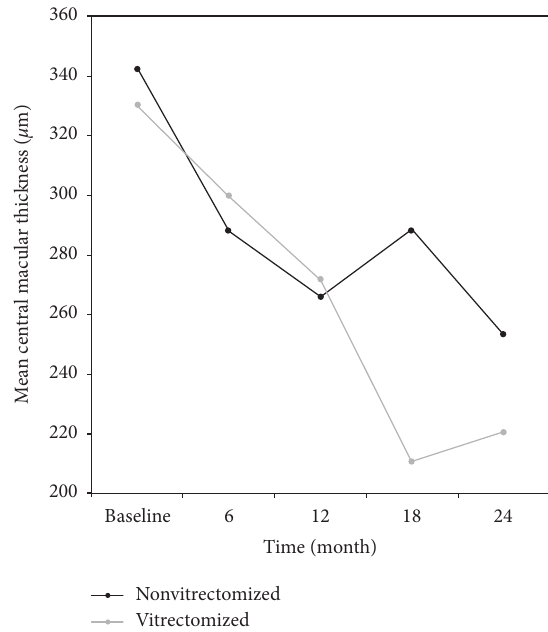
Figure 3: Changes in the mean central macular thickness ( µ ) of the study groups during 24 months of follow-up. CMTindicates central macular thickness. For CMT values, the reduction from baseline to the 12th month of the treatment was significant in the